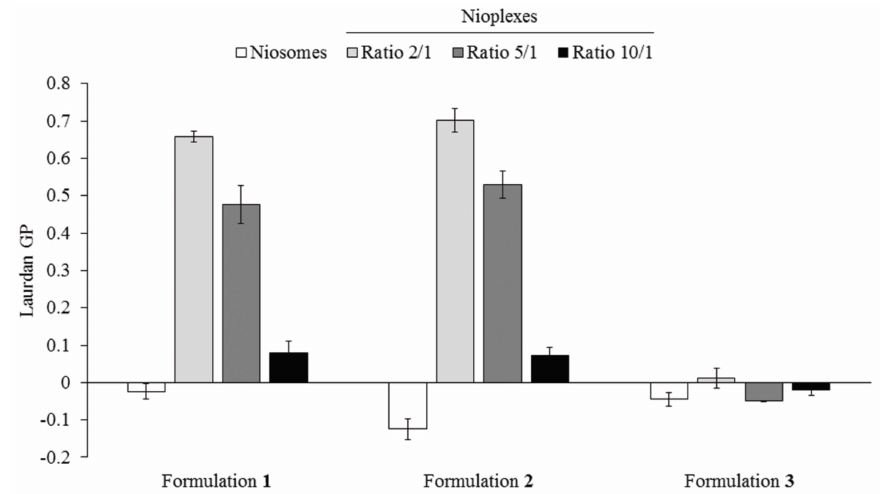
Figure 5. Laurdan general polarization (GP) values measured of niosomes based on formulations 1 , 2 and 3 and their corresponding nioplexes at cationic lipid/DNA mass ratios 2/1, 5/1 and 10/1.